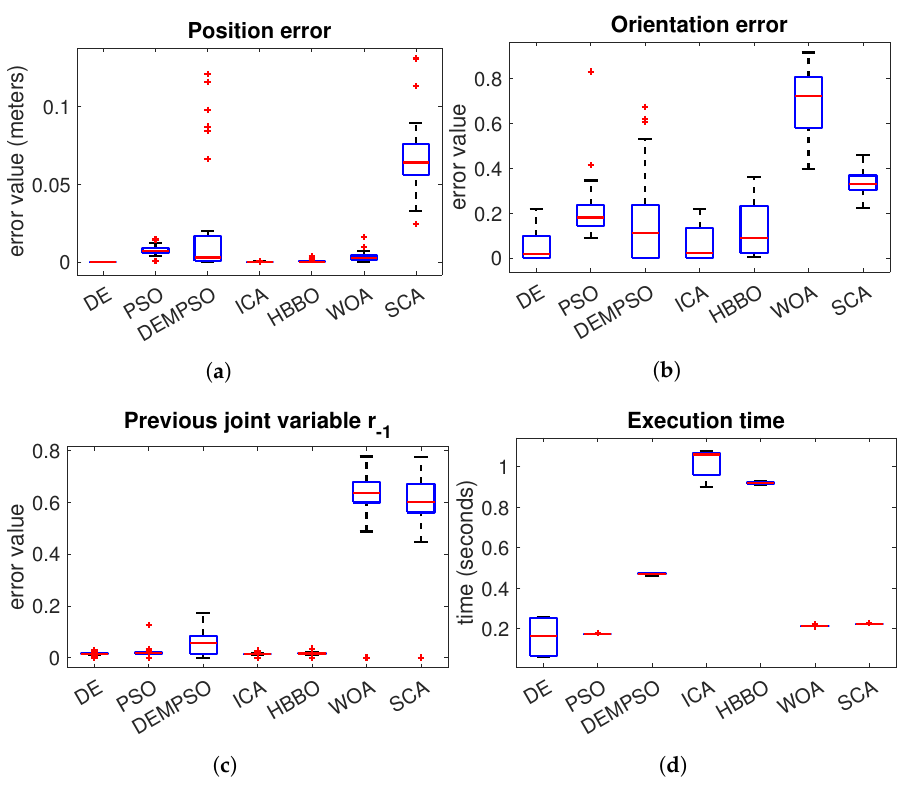
Figure 6. Circle path tracking results with the Fanuc robot. ( a ) Fanuc end-effector position error (5); ( b ) Fanuc end-effector orientation error (15); ( c ) Fanuc joint variables error (16); ( d ) Execution time for each point in the